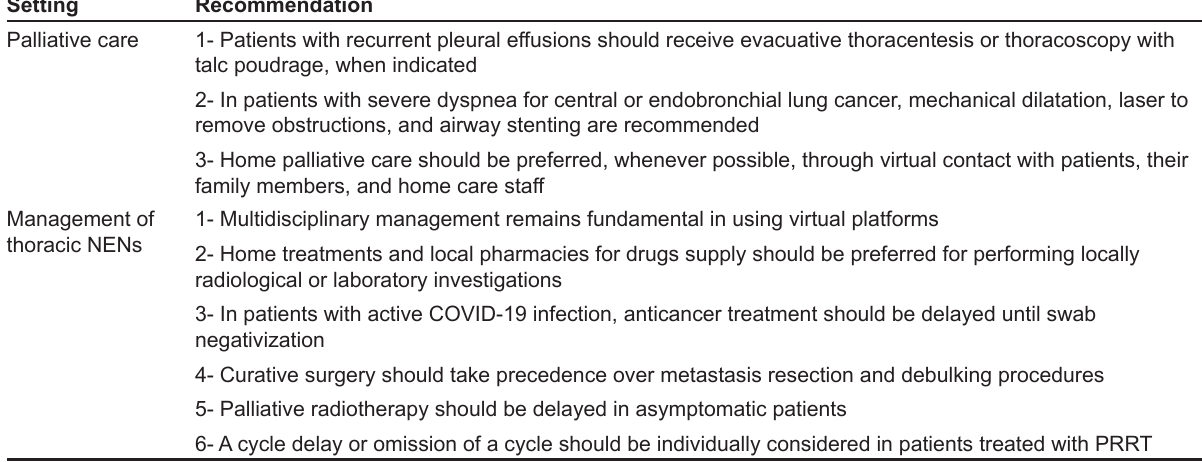
Table 1. The recommendation in lung cancer management ( continued ) Setting